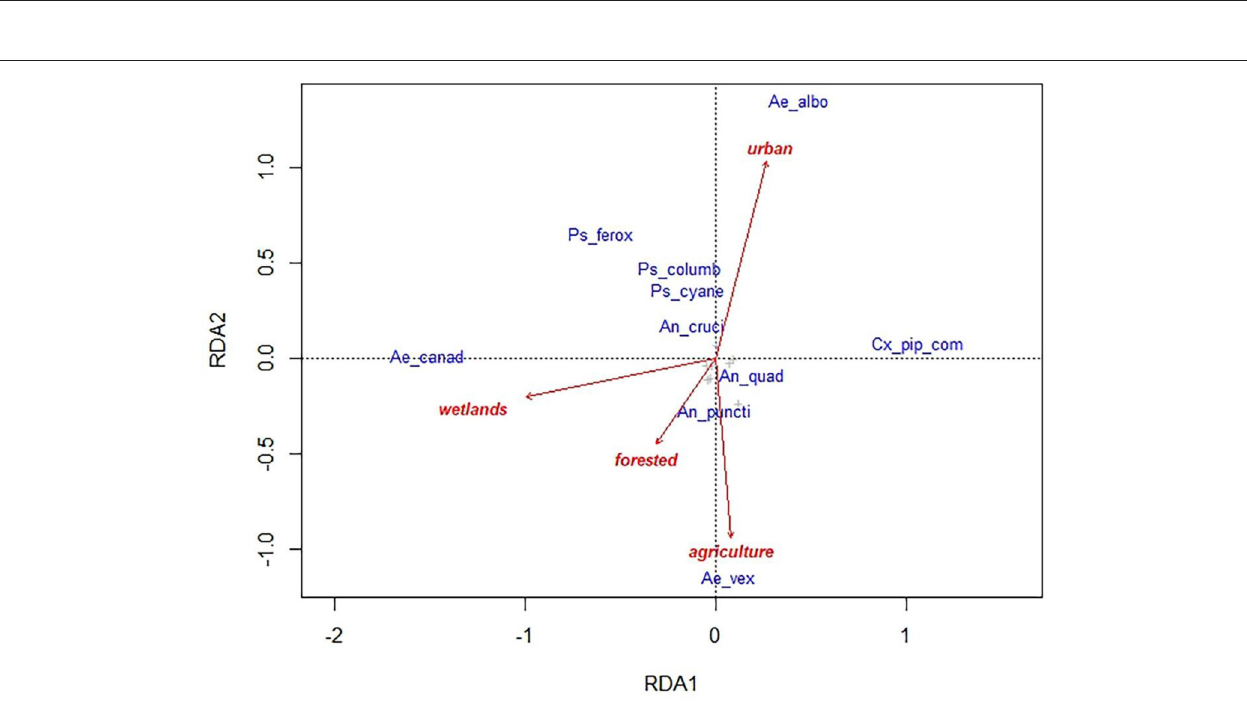
Frontiers in Public Health |